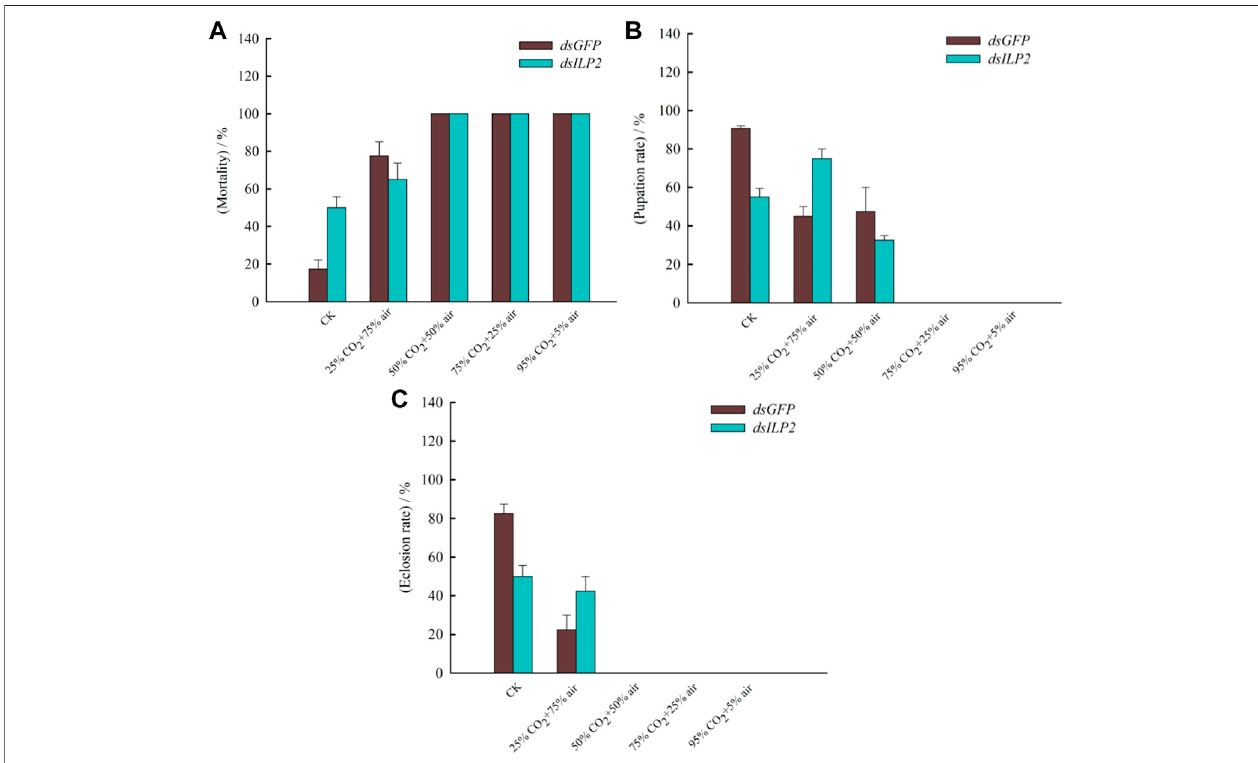
FIGURE 5 | The mortality, pupation rate, and emergence rate of the red rice pirate treated with RNAi combined with high concentration CO 2 . (A) mortality; (B) pupation rate; (C) emergence rate. T. castaneum larvae were divided into three groups, each group covered 150 larvae. The samples used to be counted mortality, pupation, and emergence